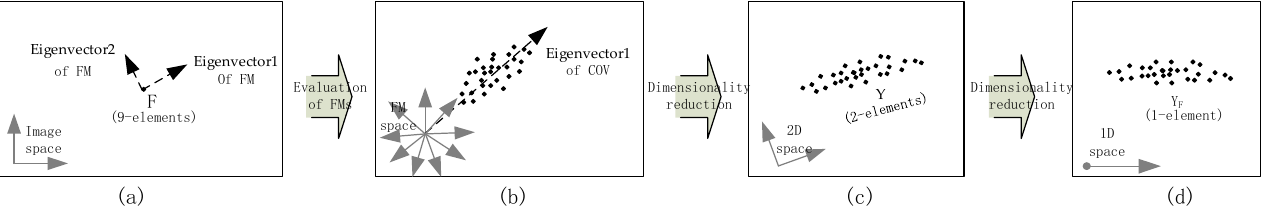
Figure 3. Conversion process of FM. ( a ) is the FM directions in 2D image space, ( b ) describes the FM error direction in 9D FM space, ( c ) and ( d ) represent the distribution of FMs in a new 2D space and 1D space, respectively.